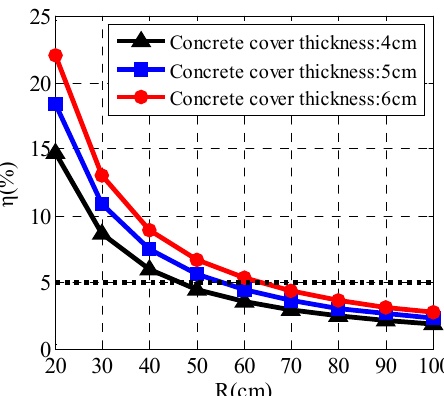
Figure 10. The e ff ect of radius on η c for di ff erent concrete cover thicknesses. Figure 10. The effect of radius on η c for different concrete cover thicknesses.